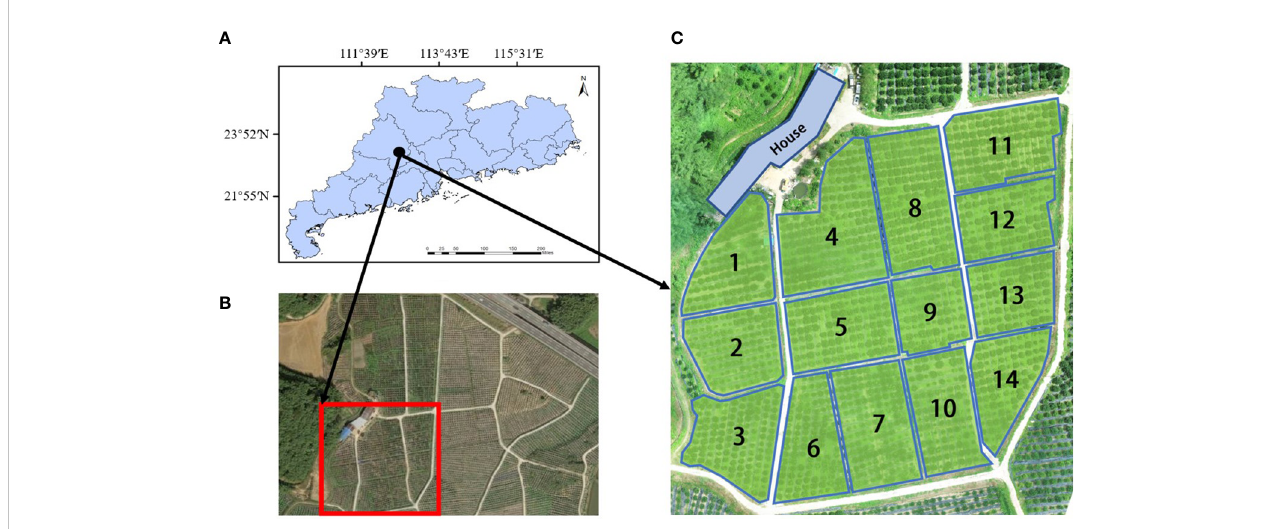
FIGURE 1 Experimental site and site division. (A) Geographic location of the experimental site, (B) Satellite map of the experimental area, (C) Division of the experimental